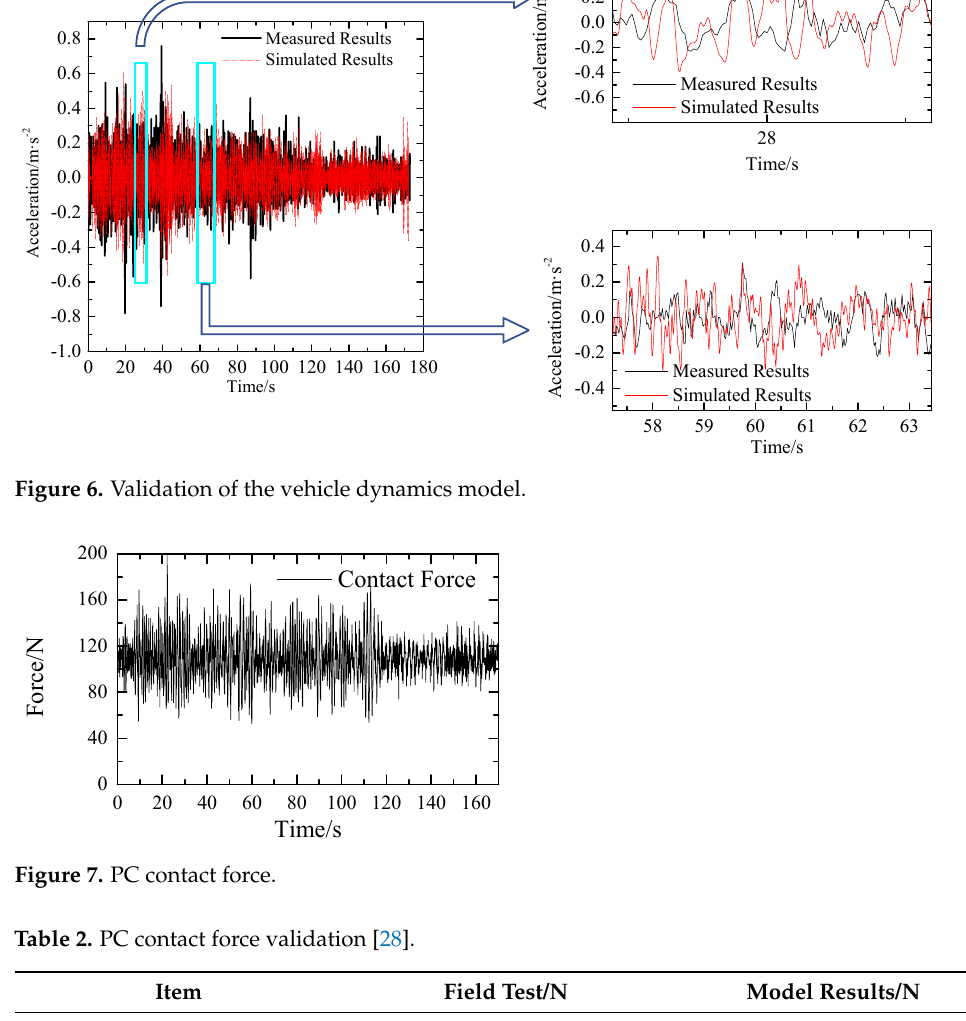
Figure 6. Validation of the vehicle dynamics model.